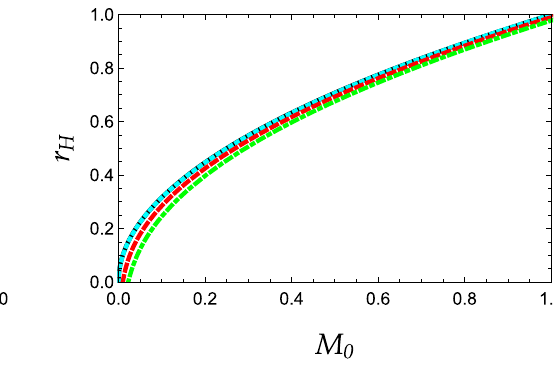
Fig. 2 Metric potentials for the obtained solutions for different values of ξ assumingaconcreteparametrizationofNewton’scouplinginspired inasymptoticallysafegravity.Leftpanel: A ( r ) versusradialcoordinate. Right panel: B ( r ) − 1 versus radial coordinate. In all four figures we fix